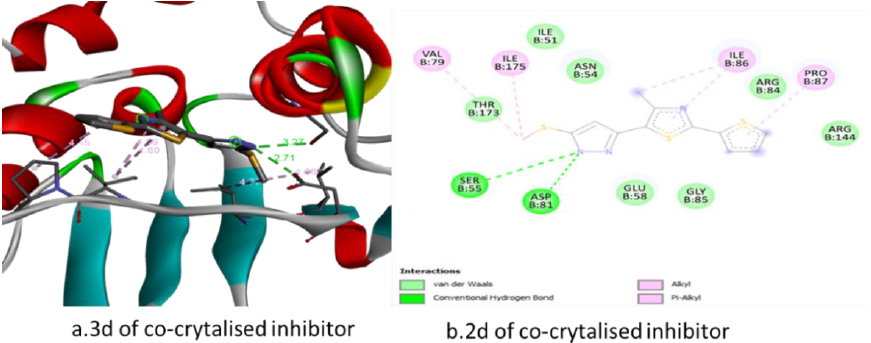
Figure 10. Interaction of the docked co-crystalized substrate with bacterial DNA gyrase B. Table 5. Docking results of the new compounds with sterol 14 α -demethylase